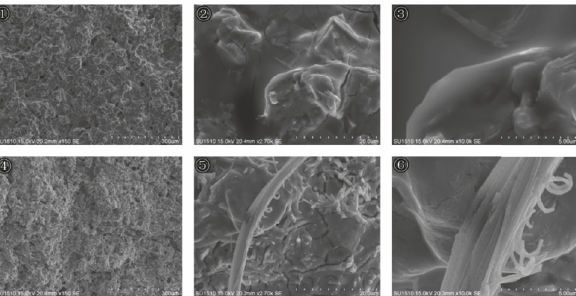
Figure 10: SEM photo of 900 ∘ C sintered samples (HLW pH=5, ABC Fe DEF 9% Fe 2 O 3 free, 2 O 3 addition).